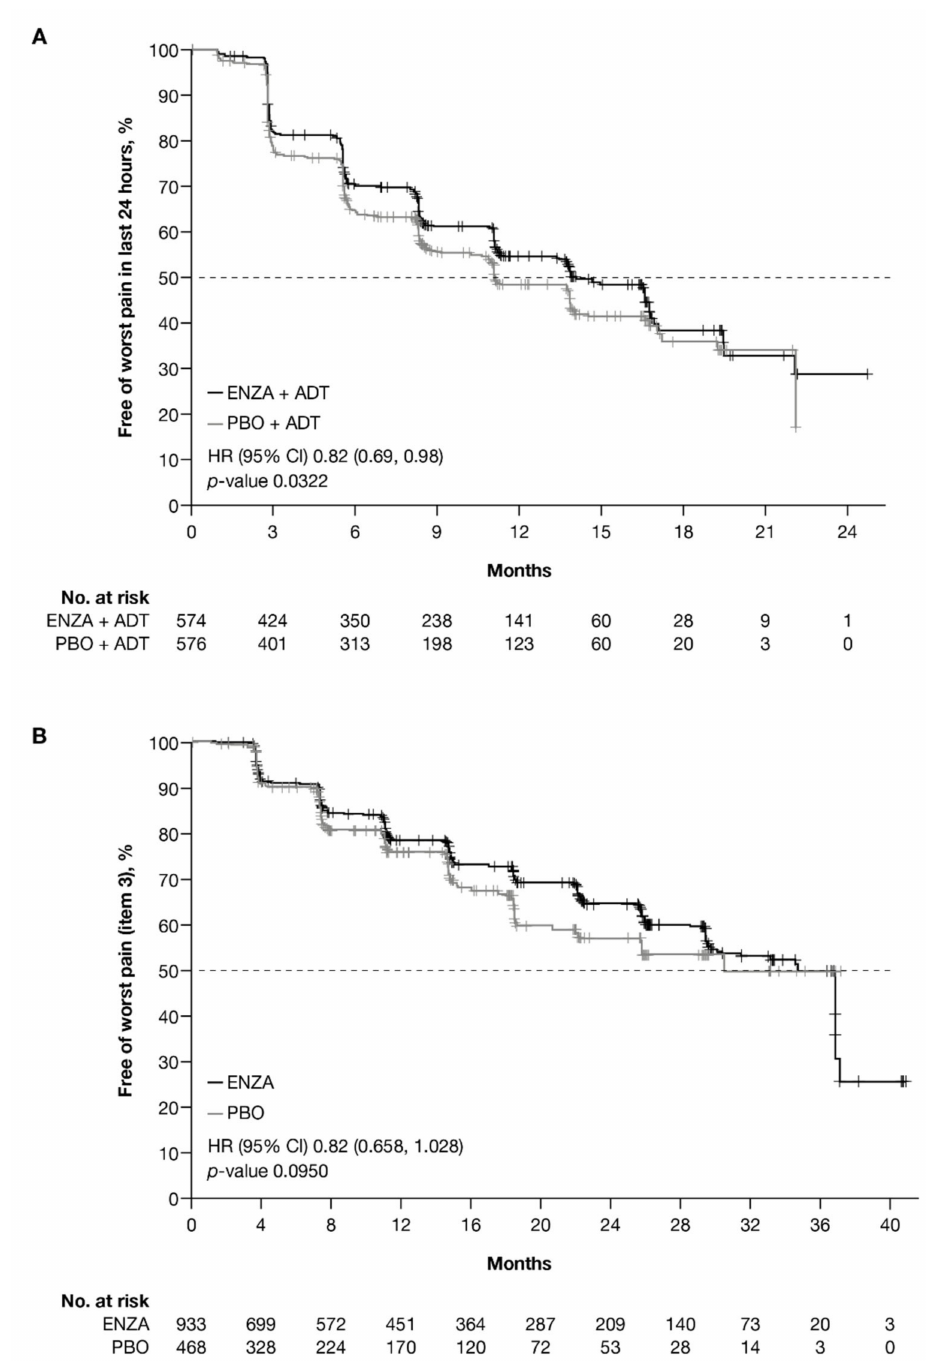
Figure A1. Kaplan–Meier curves for BPI-SF worst pain item. Free from BPI worst pain item (item 3) for ( A ) ARCHES trial patients with mHSPC and ( B ) PROSPER trial patients with nmCRPC. Abbrevi- ations: BPI: Brief Pain Inventory; BPI-SF: Brief Pain Inventory–Short Form; CI: Confidence interval; ENZA: Enzalutamide; HR: Hazard ratio; mHSPC: Metastatic hormone-sensitive prostate cancer; nmCRPC: Non-metastatic castration-resistant prostate cancer; PBO: